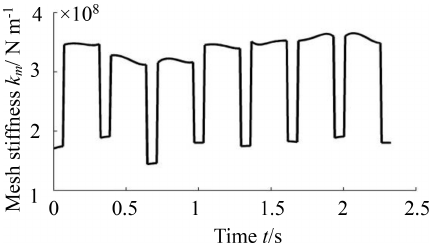
Figure 7. Synthesizing mesh stiffness of the NFG pair.